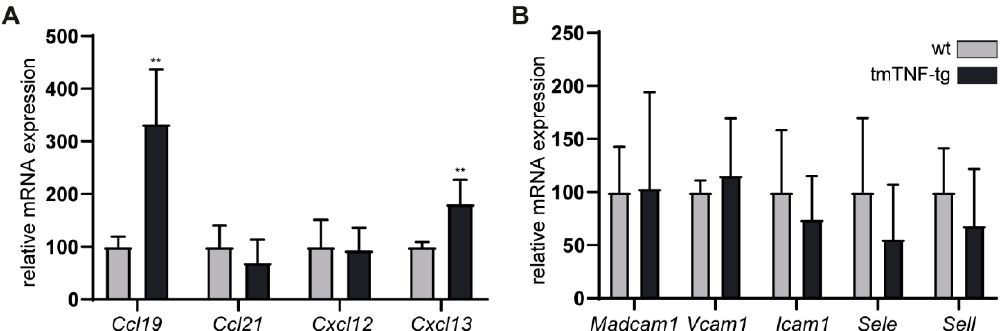
Figure 5. Expression of GC chemokines and adhesion molecules in the spleen of tmTNF-tg mice. mRNA levels of different chemokines and adhesion molecules were analyzed in spleen of tmTNF-tg mice. ( A ) mRNA expression of different GC-associated chemokines. tmTNF-tg spleen had an increase in Ccl19 and Cxcl13 . ( B ) No change in mRNA expression of different GC-associated adhesion molecules in tmTNF-tg mice. GC = germinal center; ** = p ≤ 0.01; n = 6.